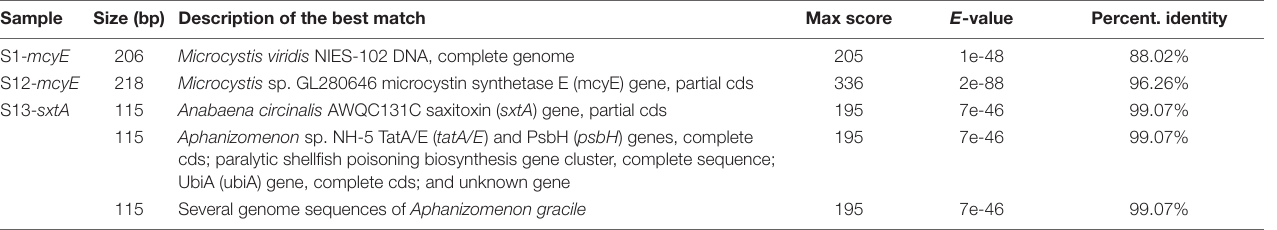
TABLE 3 | Origin and identification of mcyE and sxtA genes in environmental samples from the Ural River.